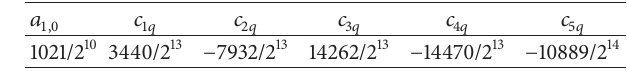
Table 4: Quantized polynomial